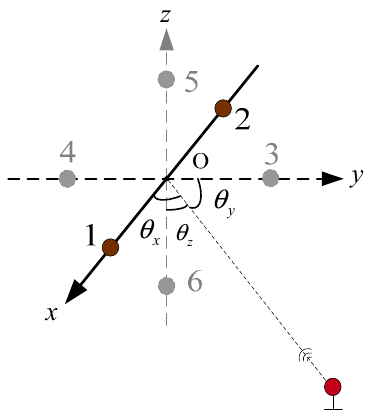
Figure 5. The schematic diagram of the USBL array structure based on the ‘rotating array and reusing elements’.